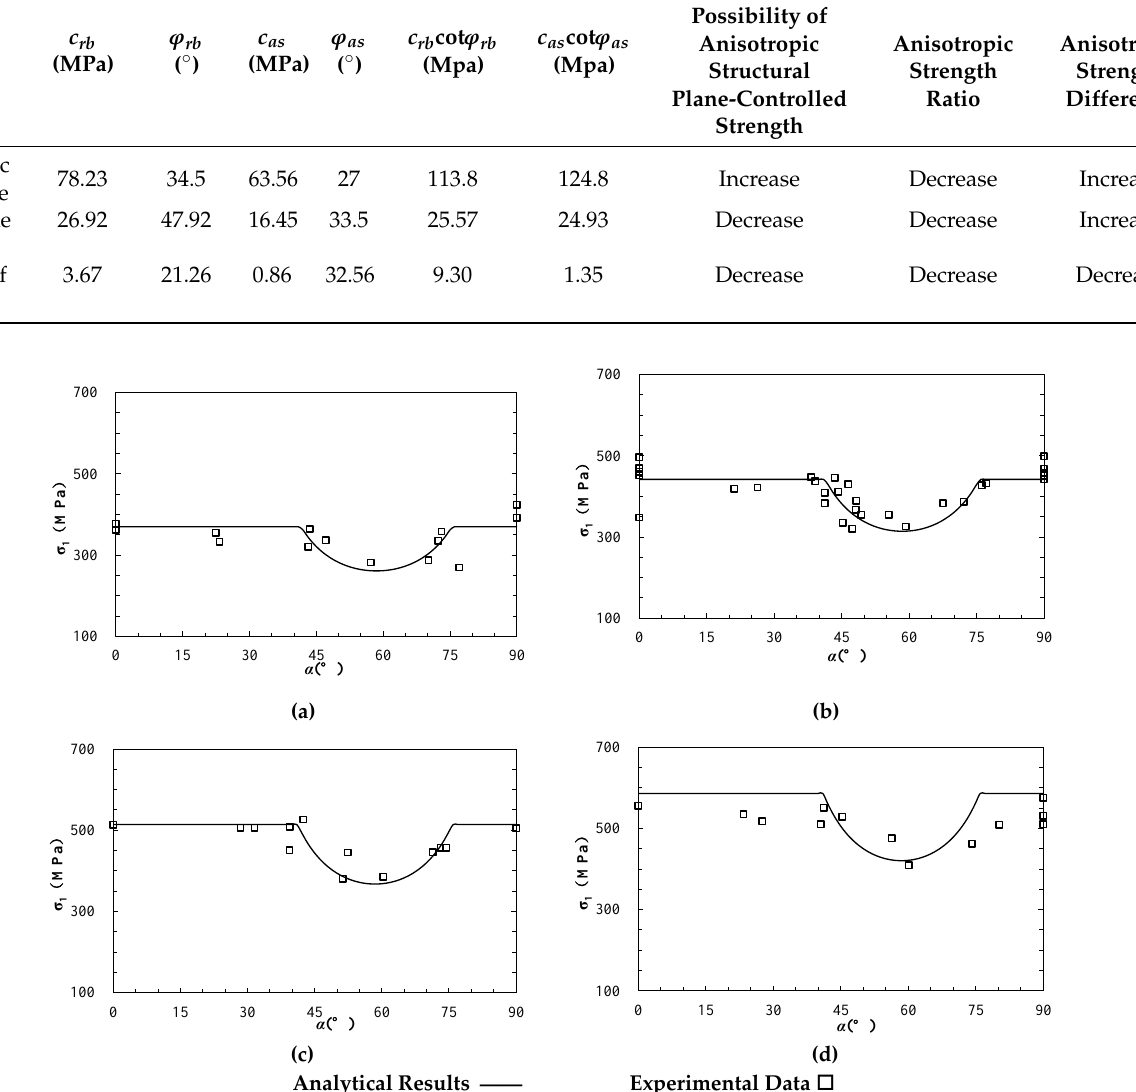
Figure 4. The analytical and experimental strength of anisotropic dolomitic limestone (modified based on [34]). ( a – d ) represent the results under triaxial compression at different confining pressure ( 𝜎 3 ) of 20, 40, 60, 80 MPa, respectively. Table 1. Strength parameters of anisotropic rock mass.